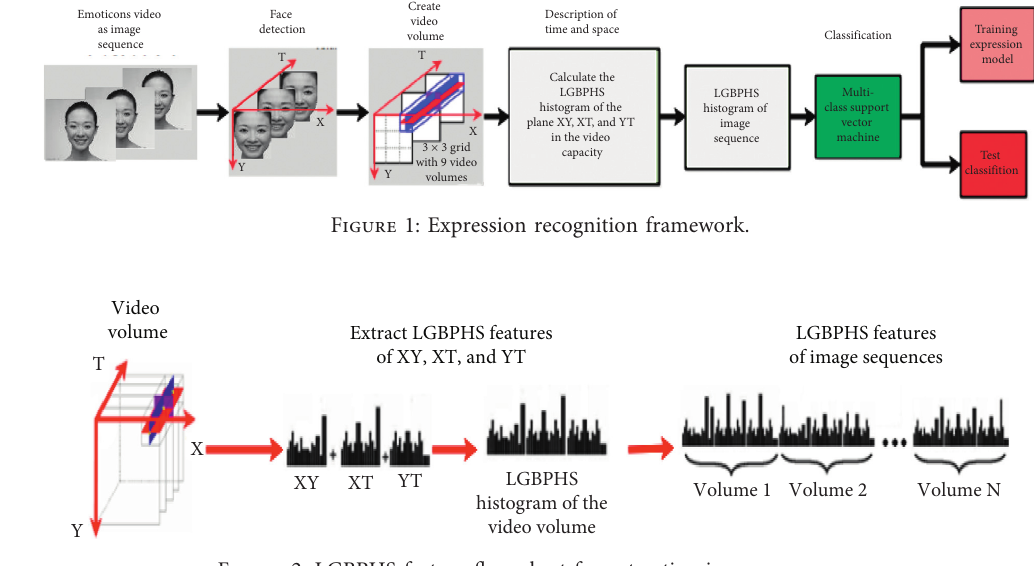
Figure 2: LGBPHS feature flow chart for extracting image